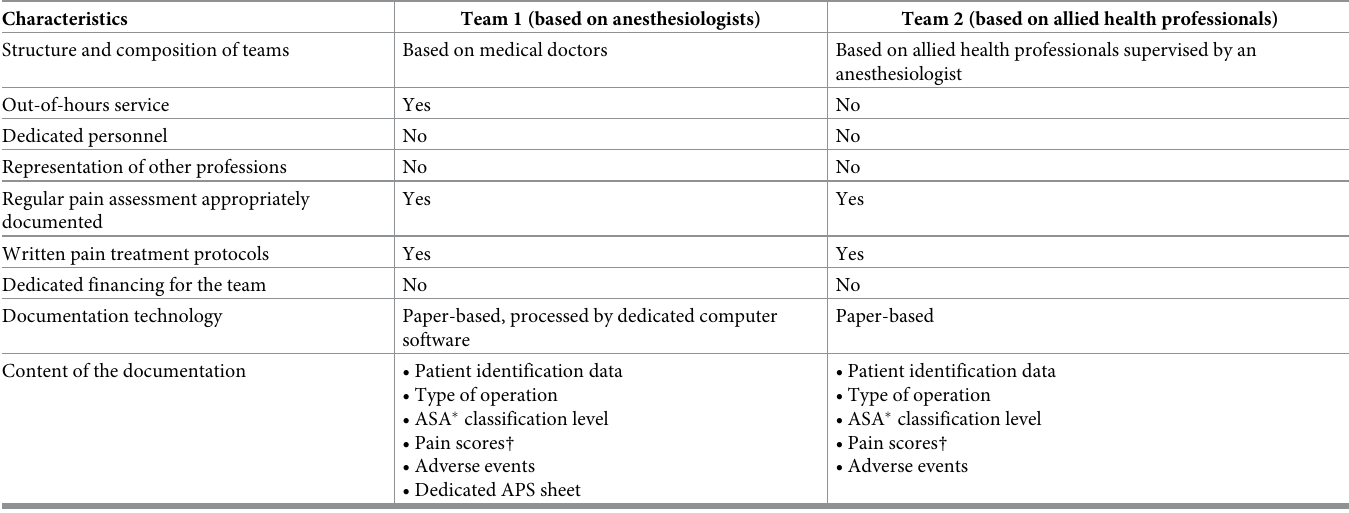
Table 4. The main characteristics of operational Acute Pain Services (APS) in two Hungarian